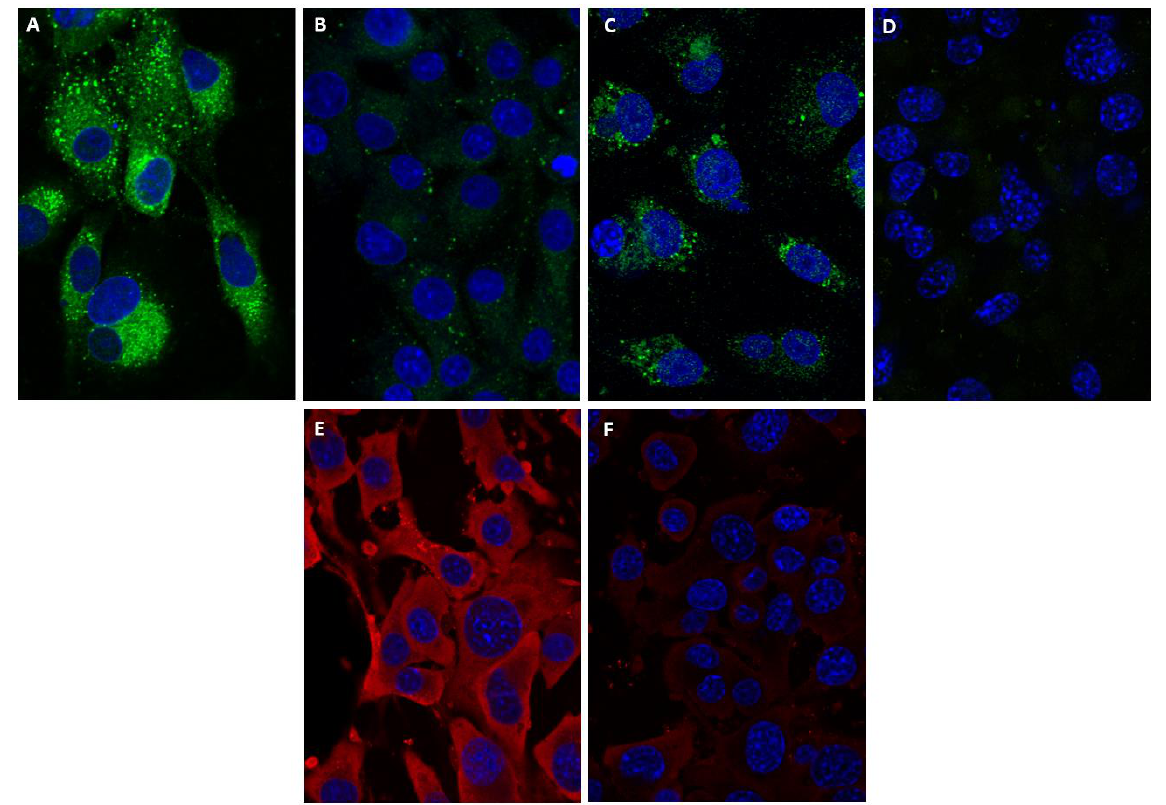
Figure 5. Confocal fluorescence microscopy of Great Island virus (GIV) or BTV infected BSR cells treated with fluvastatin. GIV infected cells were labelled with anti-GIV-NS4 (non-structural protein) and Alexa Fluor 488 (green fluorescence) conjugated anti-rabbit IgG. BTV infected cells were labelled with anti-BTV-NS4 and Alexa Fluor 488 (green fluorescence) conjugated anti-rabbit IgG or anti-BTV-8 VP2 and Alexa Fluor 568 (red fluorescence) conjugated anti-mouse IgG. Nuclei were stained with DAPI (blue). ( A ) Non-treated GIV infected cell control showing the NS4 spherical bodies. ( B ) GIV infected cells treated with fluvastatin, showing an almost complete disappearance of the NS4 spherical bodies and low levels of NS4 expression in the cells. ( C ) Non-treated BTV-8 infected-cell control showing NS4 in the cytoplasm and nucleus. ( D ) BTV infected cells treated with fluvastatin, showing an almost complete disappearance of the NS4 signal. ( E ) Non-treated BTV-8 infected-cell control showing strong expression of VP2 across the cells. ( F ) BTV-8 infected cells treated with fluvastatin, showing a significant drop of the VP2 signal.